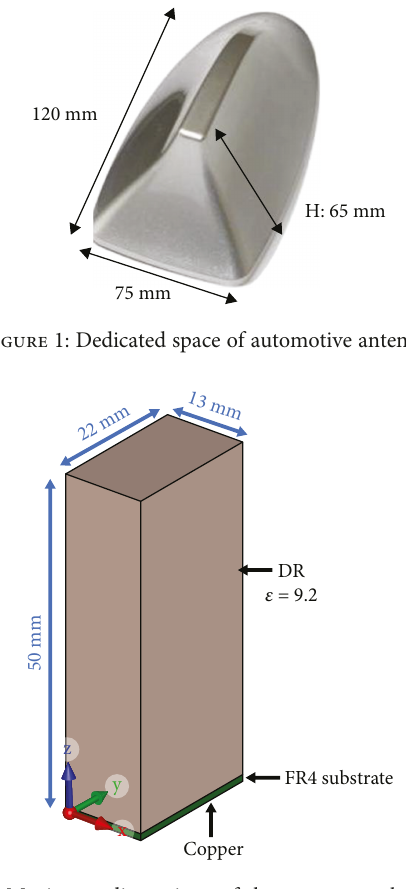
Figure 2: Maximum dimensions of the antenna to be integrated within the dedicated space presented in Figure